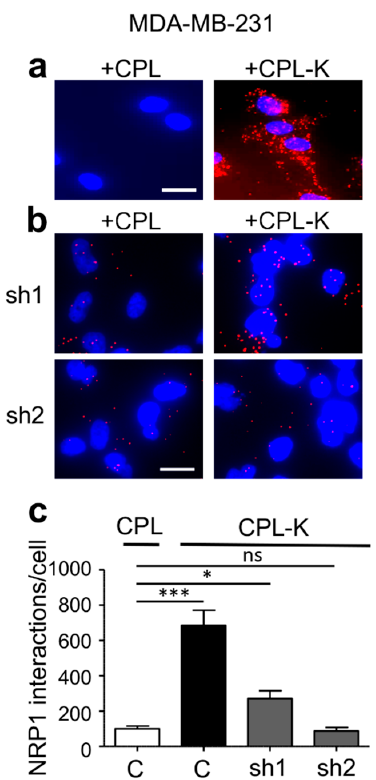
Figure 2. CPL-K interacts with Neuropilin-1 (NRP1) in MDA-MB-231 cells. ( a , b ) Proximity